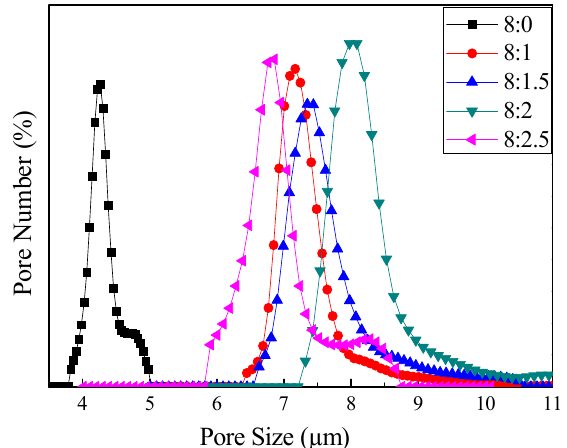
Figure 6. Through-pore size and through-pore size distribution.